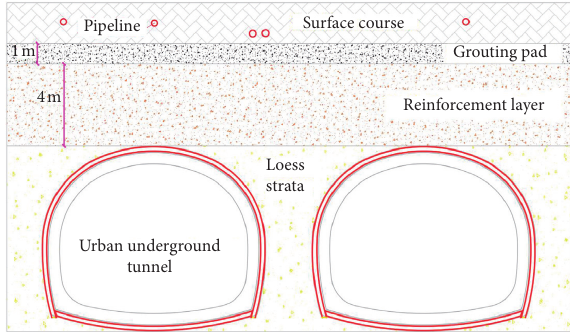
Figure 11: Layered grouting reinforcement of overlying